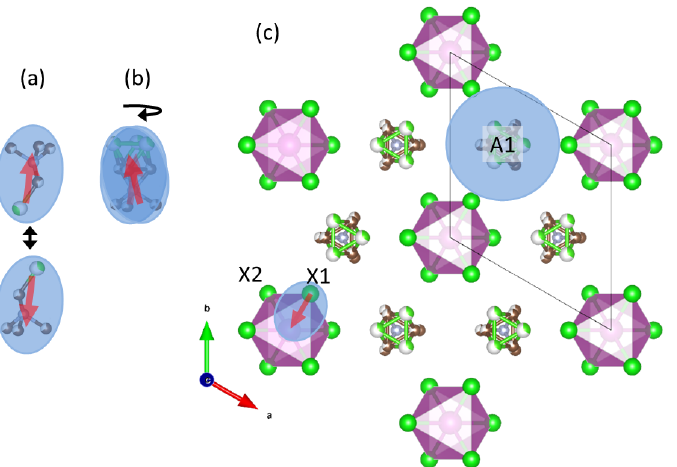
Figure 11. ( a ) TMCM molecule that reorients its major axis of 180 ◦ , reorienting its electric dipole (red arrow) in the same manner, but leaving the elastic dipole (blue ellipsoid) unchanged; ( b ) rotation of 120 ◦ of the TMCM molecule around its major axis, with little change in electric and elastic dipoles; ( c ) TMCM vacancy in site A1, with no electric dipole and elastic dipole that is isotropic within the ab plane; a Cl vacancy in X1 forms an electric and elastic dipole with one or both of its nearest neighbour Mn atoms along the c